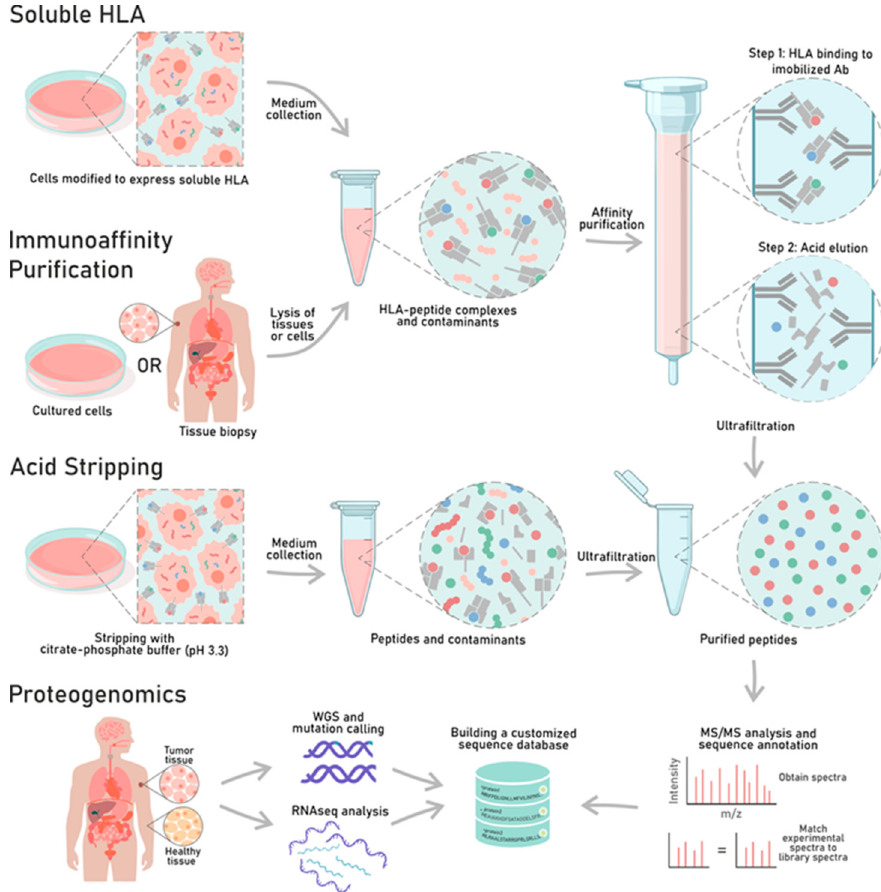
Figure 2. Workflow of the main approaches for the isolation of human leucocytes antigen (HLA)-I restricted peptides. In vitro methods for HLA enrichment are depicted. The direct isolation and identification of the peptides present in the HLA complex can be achieved through different approaches, such as the use of acid stripping, soluble HLA, immunoaffinity purification, and the proteogenomic. The purified peptides are then resolved by mass spectrometry analysis, and the spectra can be searched against a conventional database or a customized database (proteogenomic